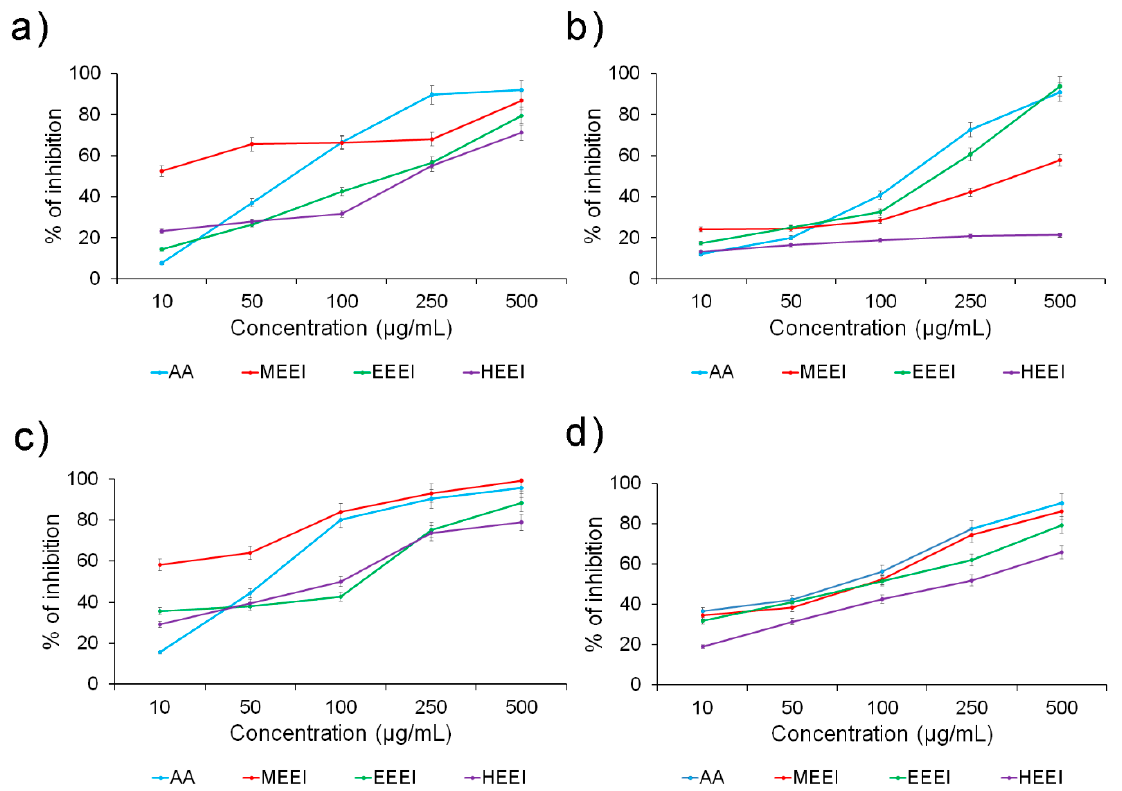
Figure 2. Antioxidant scavenging capacity of the different solvent extracts from Enteromorpha intestinalis as determined by ( a ) DPPH • radical scavenging activity, ( b ) hydrogen peroxide (H 2 O 2 ) scavenging activity, ( c ) hydroxyl ( • OH) ion radical scavenging activity, and ( d ) superoxide ( • O 2 ) scavenging activity assays. Table 4. IC 50 values (in µg/mL) obtained from the free radical scavenging assays with ascorbic acid and the Enteromorpha intestinalis extracts.